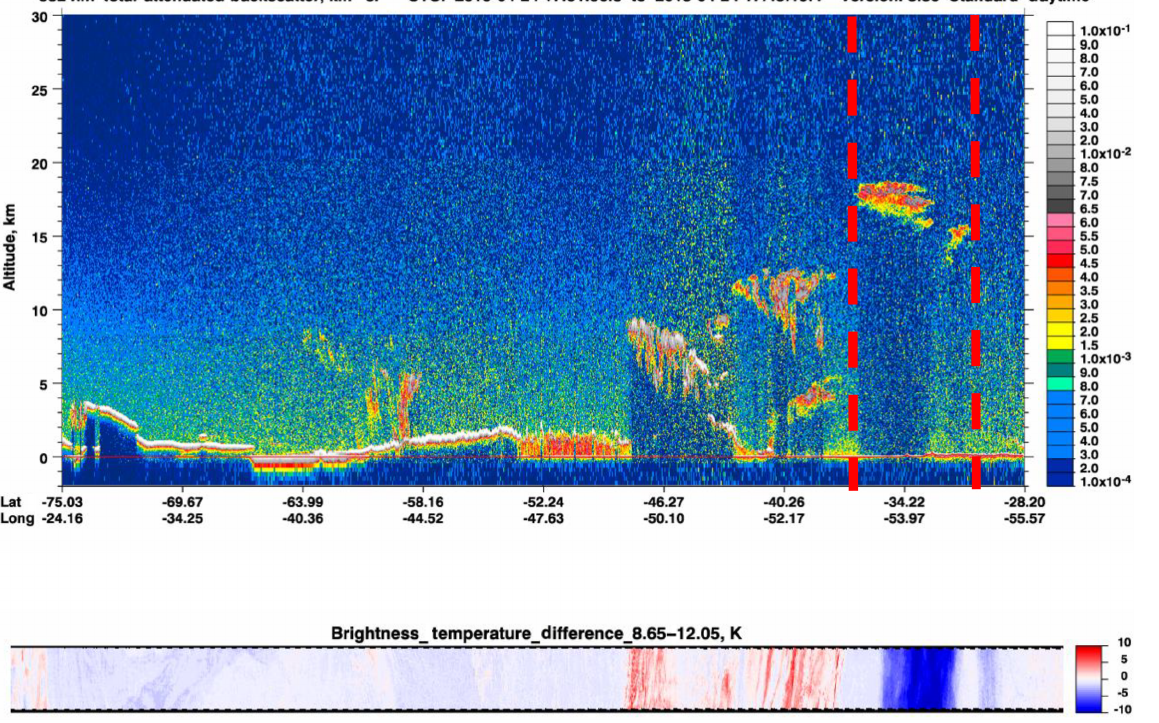
Figure 3. CALIOP cross section of 532nm attenuated backscatter and brightness temperature difference for the overpass at 17:30–17:45UTC on 24 April 2015 over South America from 28 to 75 ◦ S latitude. The two red dashed lines delimit the geographical region where the Calbuco plume is observed by CALIOP on 24 April